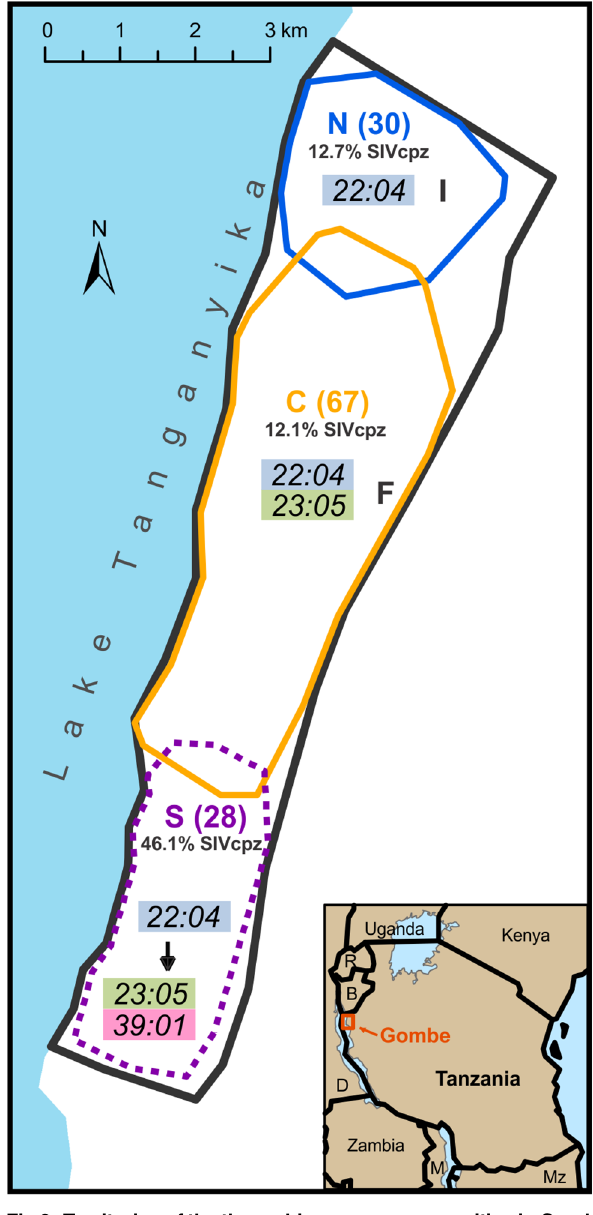
Fig 2. Territories of the three chimpanzee communities in Gombe National Park. Gombe National Park is small, covering 35 square kilometers of mountainous terrain in northwest Tanzania and has many streams that flow into Lake Tanganyika. The thick black line in the map shows the park boundary. The blue line denotes the territory in 2010 of the northern community (N), the orange line denotes the territory of the central community (C), and the dashed purple line denotes the approximate territory of the southern community (S). The inset map shows the location of the park, both within Tanzania and relative to other East African countries: Rwanda (R), Burundi (B), Democratic Republic of Congo (D), Malawi (M), and Mozambique (MZ). Within each community, the number of individuals sampled is given in parentheses, followed by the mean SIVcpz prevalence [16]. Shown for each community are the high-frequency Patr-B alleles. The expanding northern and central communities maintained the same high-frequency alleles throughout the study (1995 – 2010), while it changed in the southern community, as shown by the arrow. Immigrant females (indicated by “ I ” ) and their progeny were responsible for the high-frequency allele in the north, whereas in the central community, that role was played by the progeny of fecund males and females (indicated by “ F ” ). The map was created by Steffen Foerster, The Jane Goodall Institute Research Center, Duke University.